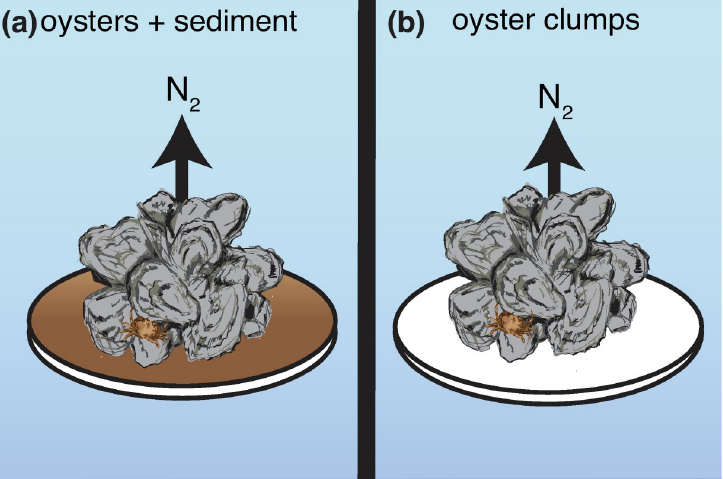
Fig 2. Diagram of incubation chamber setup. Diagram of (a) acclimated reef segments (oysters and sediment) for dark and light incubations and (b) oyster clumps alone for dark